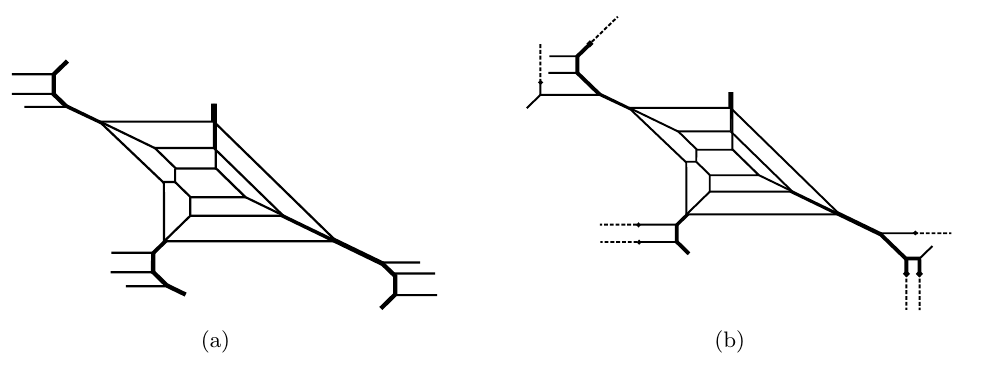
; N F = 19 obtained by 2 2